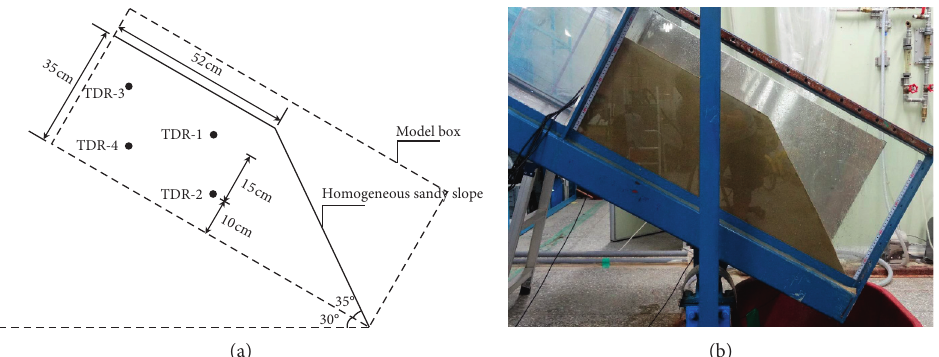
Figure 2: Model chamber of the sandy slope. (a) Geometry of the model slope and configuration of sensors. (b) Side